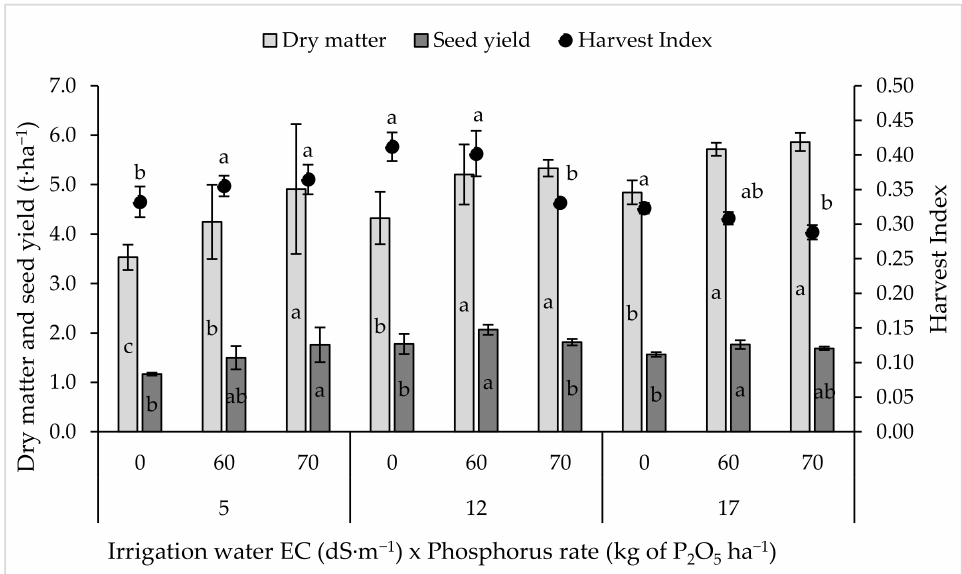
Figure 1. Seed yield, dry matter yield, and harvest index of quinoa as affected by irrigation water salinity and phosphorus rate. Any two values within a column are significantly different ( p ≤ 0.05) if they have no letter in common. The same letters indicate the statistically homogeneous groups. Error bars indicate the standard